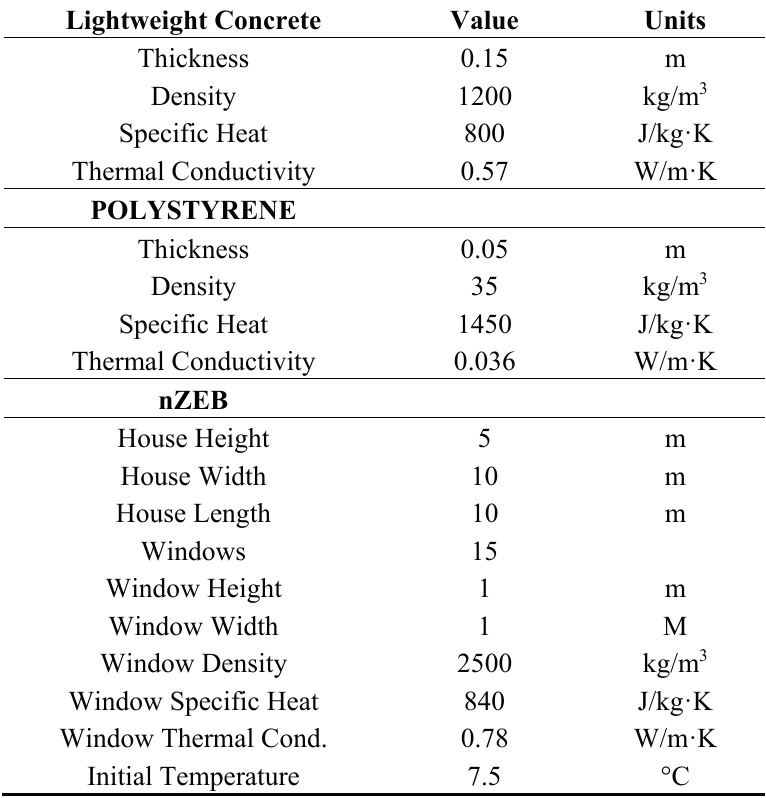
Table 2. Wall layers